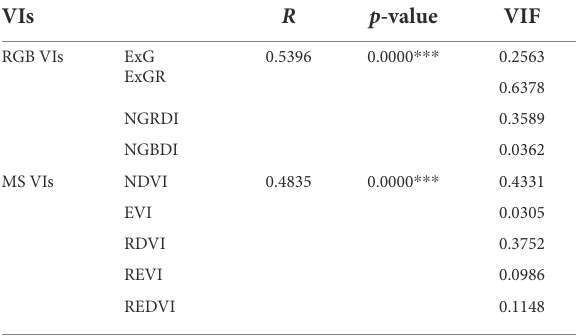
TABLE 6 Selection results of VIs using Lasso